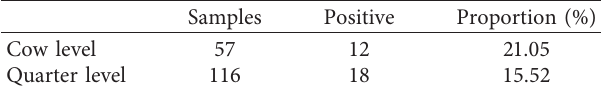
Figure 3: (a) Bacterial cell suspension turbidity measurement using a densitometer, measuring for 0.5 McFarland equivalence. (b) Antimicrobial discs applied on Mueller-Hinton agar by the disk diffusion method. Table 1: Proportion of Staphylococcus aureus isolated from clinical mastitis at cow and quarter levels.